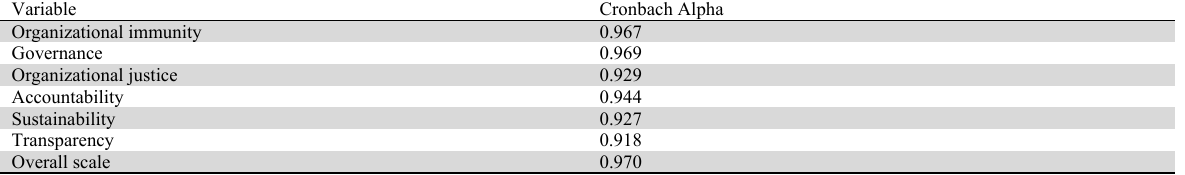
Reliability coefficients according to the Cronbach alpha coefficient of the study tool and its dimensions Variable